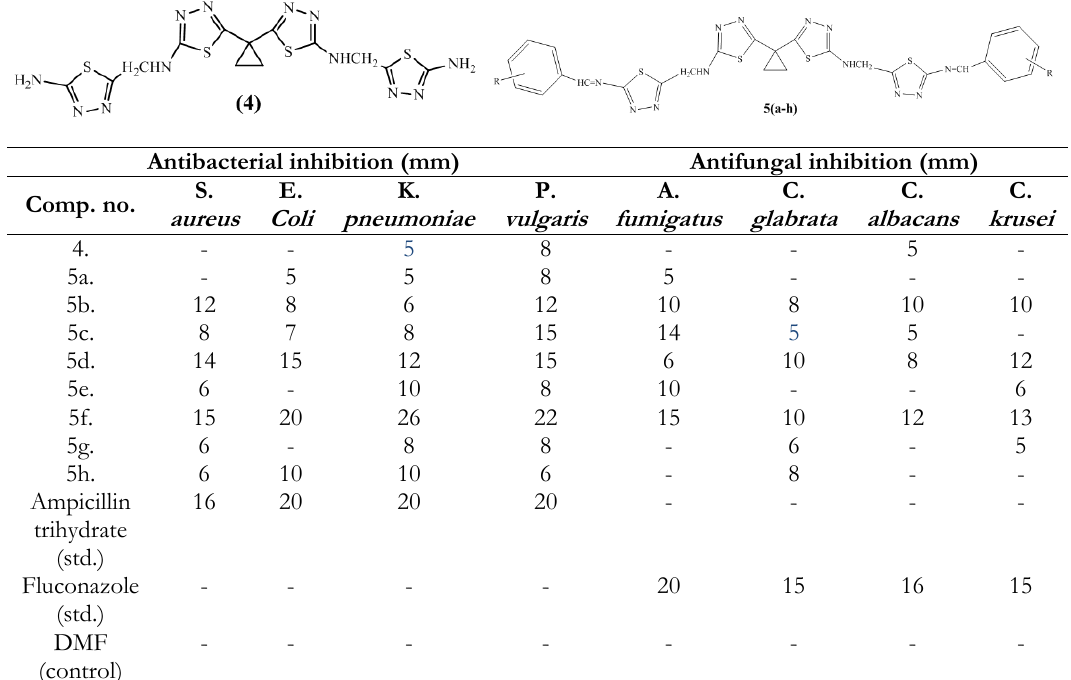
Table I. Antimicrobial data for the synthesized compounds 4 and 5(a-h).